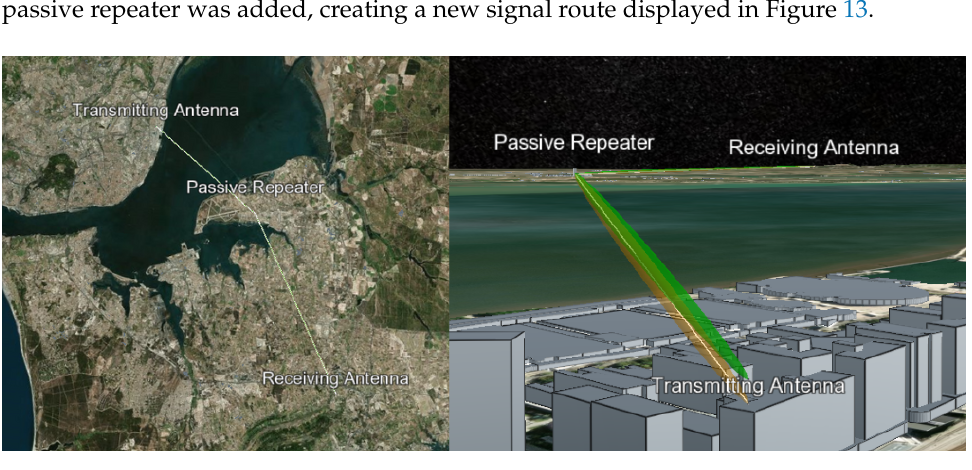
Figure 13. Simulated terrestrial project link with passive